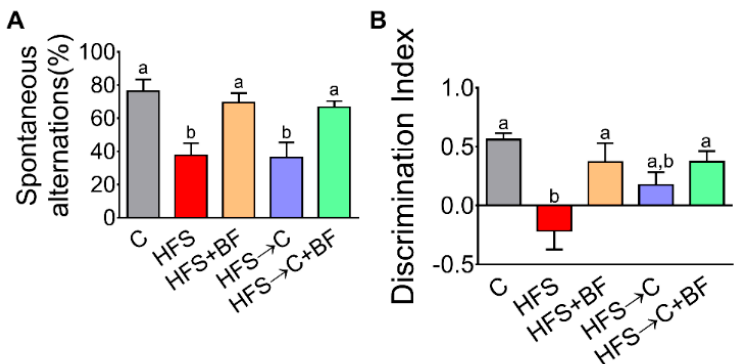
Figure 8. Consumption of bioactive foods improved spatial and working memory. ( A ) Spontaneous alternation by T-maze test and ( B ) discrimination index by novel object recognition (NOR) test in rats fed control (C) or high fat diet + 5% sucrose (HFS) with or without bioactive foods. Data are expressed as the mean ± SD. Mean values with different letters show statistical differences between each other. Data were analyzed by one-way ANOVA followed by Tukey post-hoc test. Results were considered statistically significant at p < 0.05.